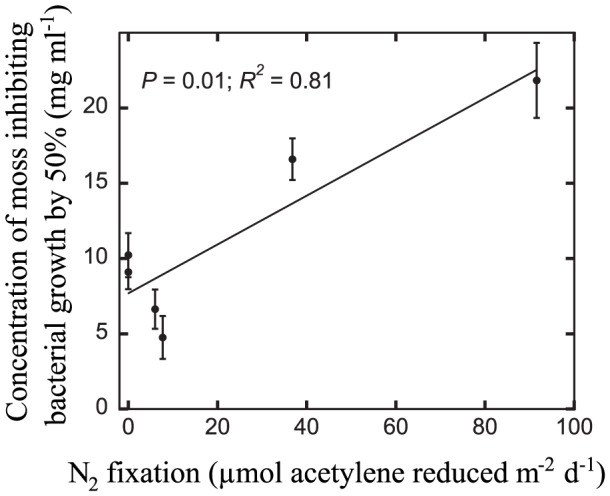
Relation between EC50 values as an index for moss toxicity and N2 fixation rates in P. schreberi.Lower EC50 values indicate higher toxicity, and vice versa. Shown are mean values ±SE derived from the inhibition curves (Fig. 1).